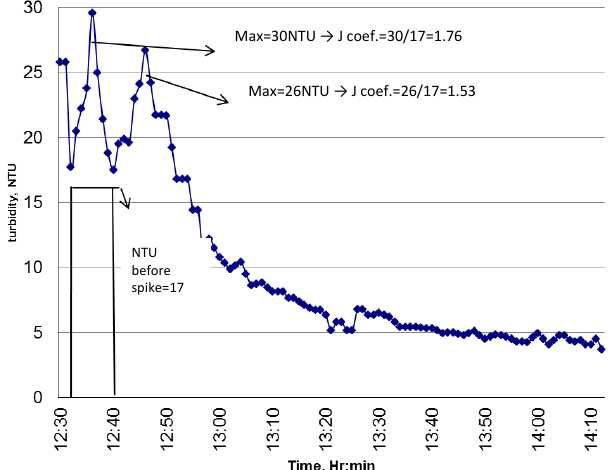
Figure 4. The turbidity pattern from UDF and schematic (graphi- cal) representation for obtaining the algorithm for the J coe ffi cient for a certain location.